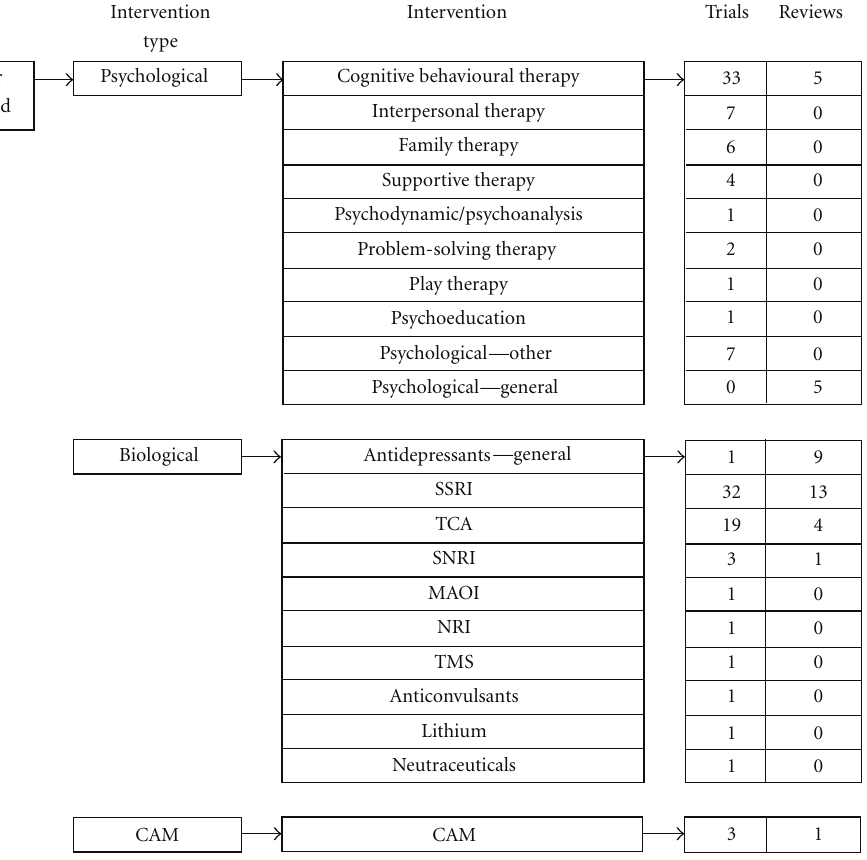
Figure 4: Distribution of included studies to treat a diagnosed depressive